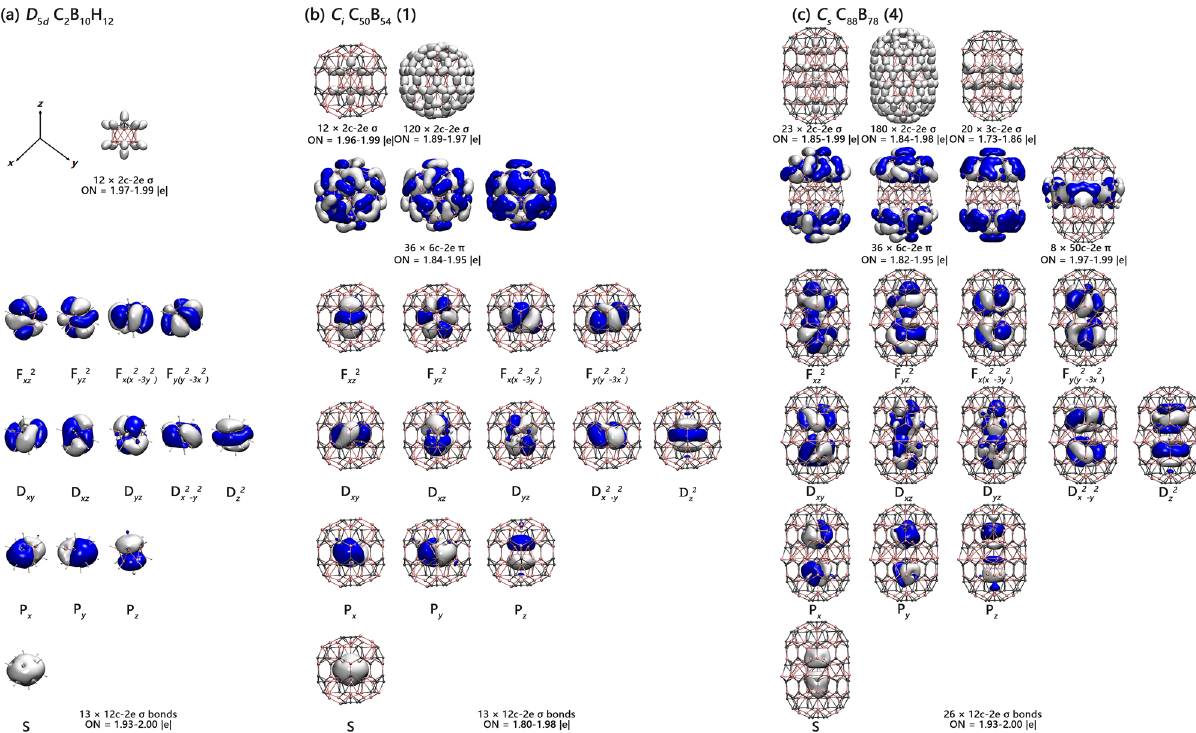
Figure 3. AdNDP bonding patterns of ( a ) D 5 d C 2 B 10 H 12 , ( b ) C i C 50 B 54 ( 1 ), and ( c ) C s C 88 B 78 ( 4 ) with the occupation numbers (ONs) Table S2). C s B 184 ( 9 ) as the most stable species on the E c ~ n curve contains two closo -B 12 icosahedral cores doubly bound to an interstitial B